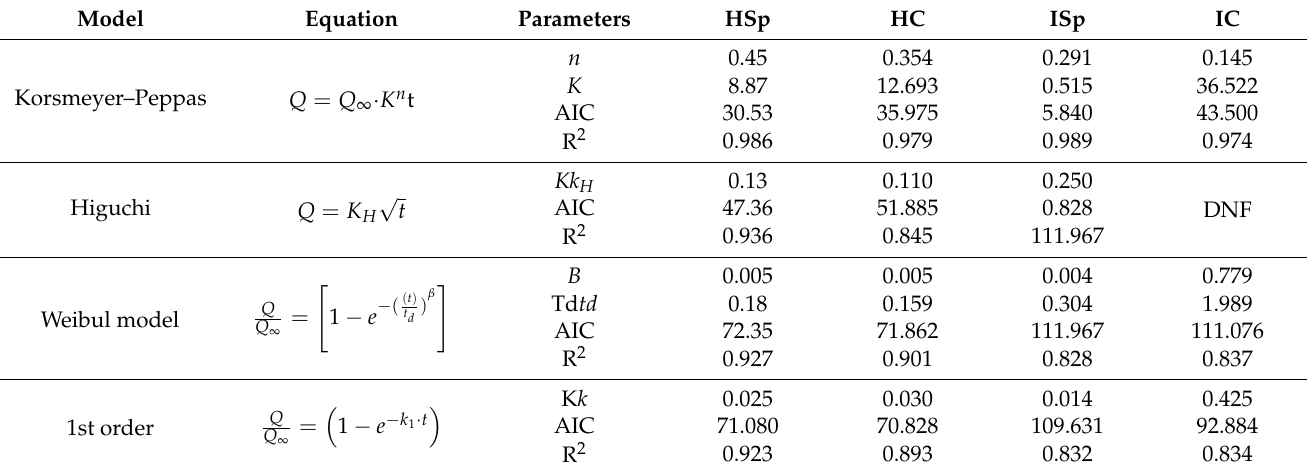
Table 4. Selected models applied for the evaluation of RSP release and statistical